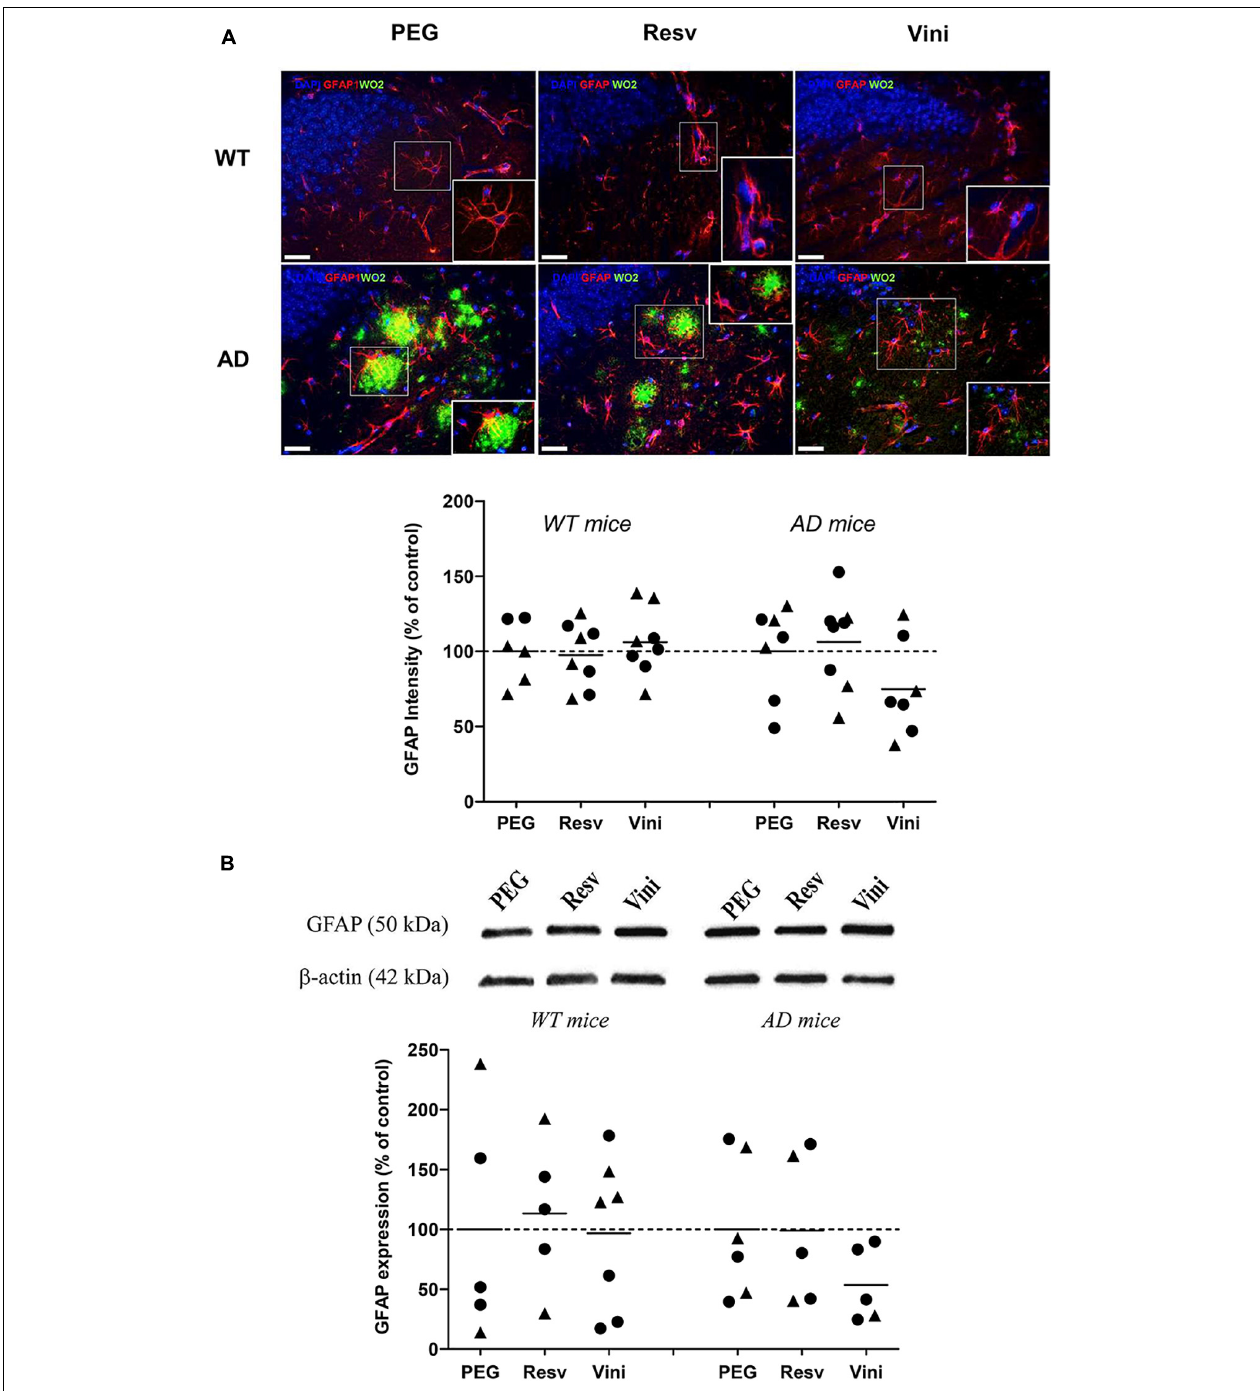
FIGURE 3 | Effects of resveratrol and viniferin on the reactivity of astrocytes. The WT mice and the double transgenic APPswePS1dE9 mice were treated with resveratrol, trans ε -viniferin or their vehicle (PEG 200) intraperitoneally from 7 to 11 months of age. (A) The senile plaques were stained with antibody against amyloid peptide (clone WO2, green), astrocytes with antibody against GFAP (red), and the nuclei with DAPI (blue). On each image, a magnification delineated by a white frame was added. The immunofluorescent GFAP signal was quantified as described in section “Materials and Methods.” Scale bars: 25 µ m. (B) Cropped blots of GFAP and corresponding β -actin were shown and GFAP/ β -actin ratios were calculated. The means of GFAP levels were represented for all groups. The results were expressed as percentage of PEG-treated mice as controls (rounds represent females, triangles represent males). The dotted line represents 100% signal. To compare values between PEG- and polyphenol-treated-mice (by trans resveratrol or trans ε -viniferin), Kruskal–Wallis test followed by Dunn’s test were used ( n = 4–8). Any significant result was observed. Full-length blots are presented in Supplementary Figure 4 .